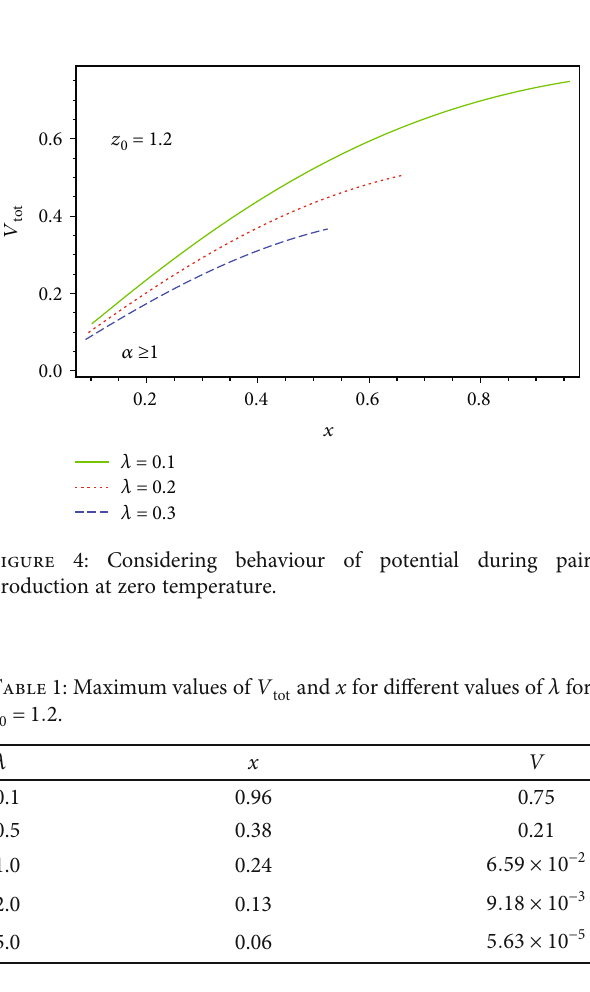
Figure 3: Considering behaviour of α along the z axis at zero temperature with di ff erent values of scale parameter.